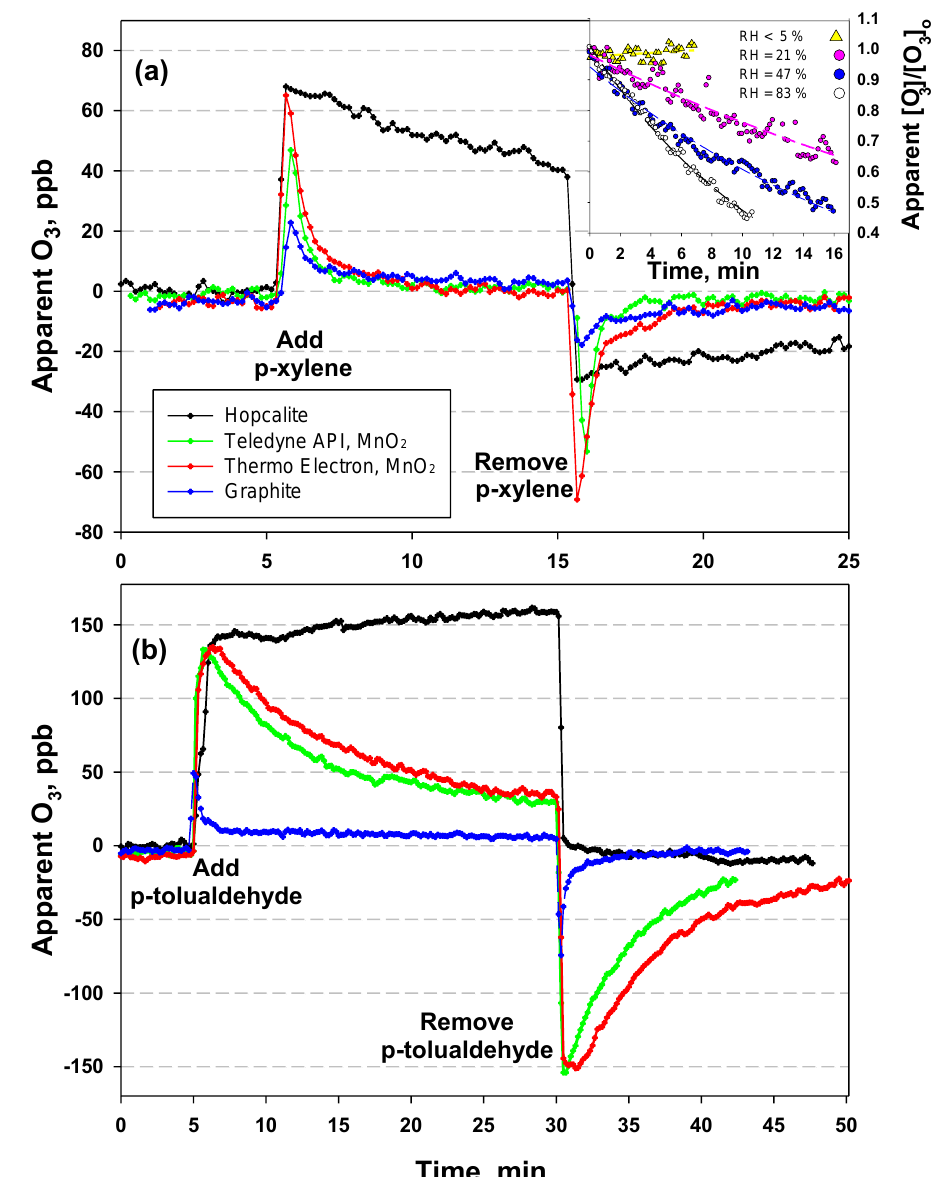
Figure 8. (a) Plot of the temporal behavior of the apparent ozone at 38% RH as 1.2ppm of p -xylene is added ( t = 5min) and then removed ( t = 15min) from ozone-free air for various scrubbers. Inset: temporal decay of the fractional apparent ozone ([O 3 ] o = initial concentration) as a function of relative humidity upon addition of ∼ 1.3ppm of p -xylene to a Model 202 analyzer equipped with a packed-bed Hopcalite scrubber. (b) Temporal behavior of the apparent ozone at 75% RH as ∼ 90ppb of p -tolualdehyde was added ( t = 5min) and then removed ( t = 30min) for various